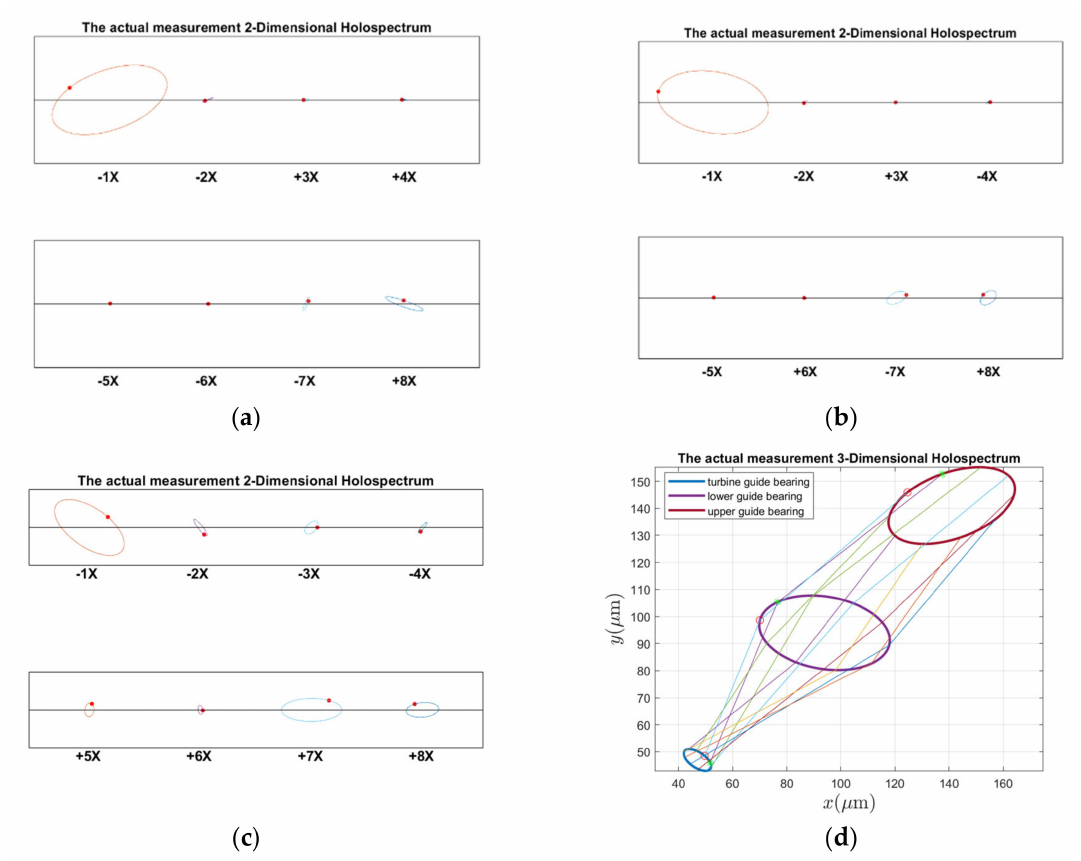
Figure 21. Shafting vibration holospectra of actual measurements: ( a ) Upper guide bearing 2D holospectrum, ( b ) Lower guide bearing 2D holospectrum, ( c ) Hydro-turbine guide bearing 2D holospectrum, ( d ) One-fold frequency 3D